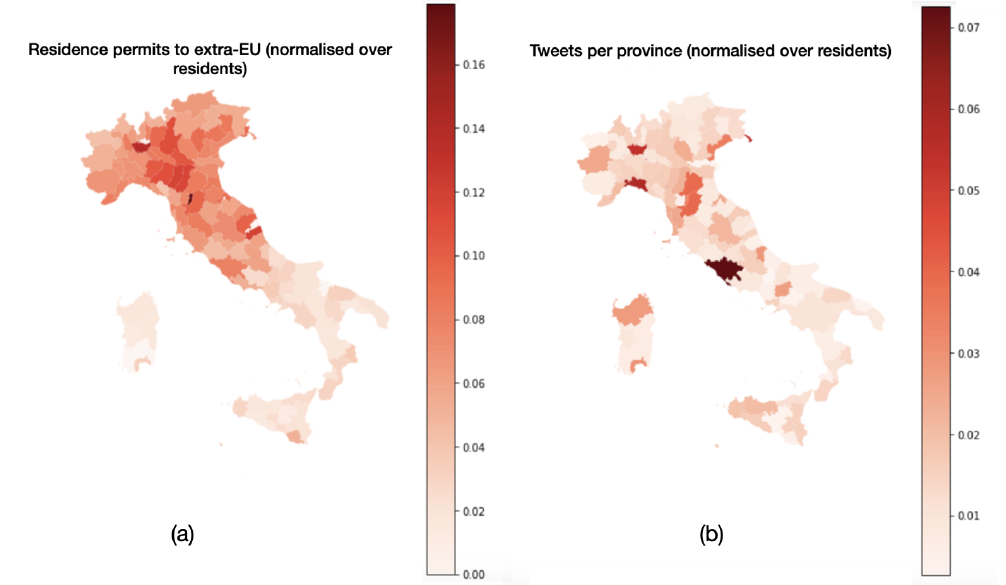
Figure 2. Spatial distribution of the geolocated tweets ( b ) compared to the distribution of residence permits per province ( a ). Both are normalised over the number of residents per province. We can observe that the provinces that display the highest activity are Rome, Milan and Genoa. It is also clearly visible the gap in terms of Twitter activity—at least on this specific topic—between northern and southern Italy. The correlation with residence permits appears to be low (Pearson’s correlation coefficient = 0.37, with p -value = 8.08 × 10 − 5